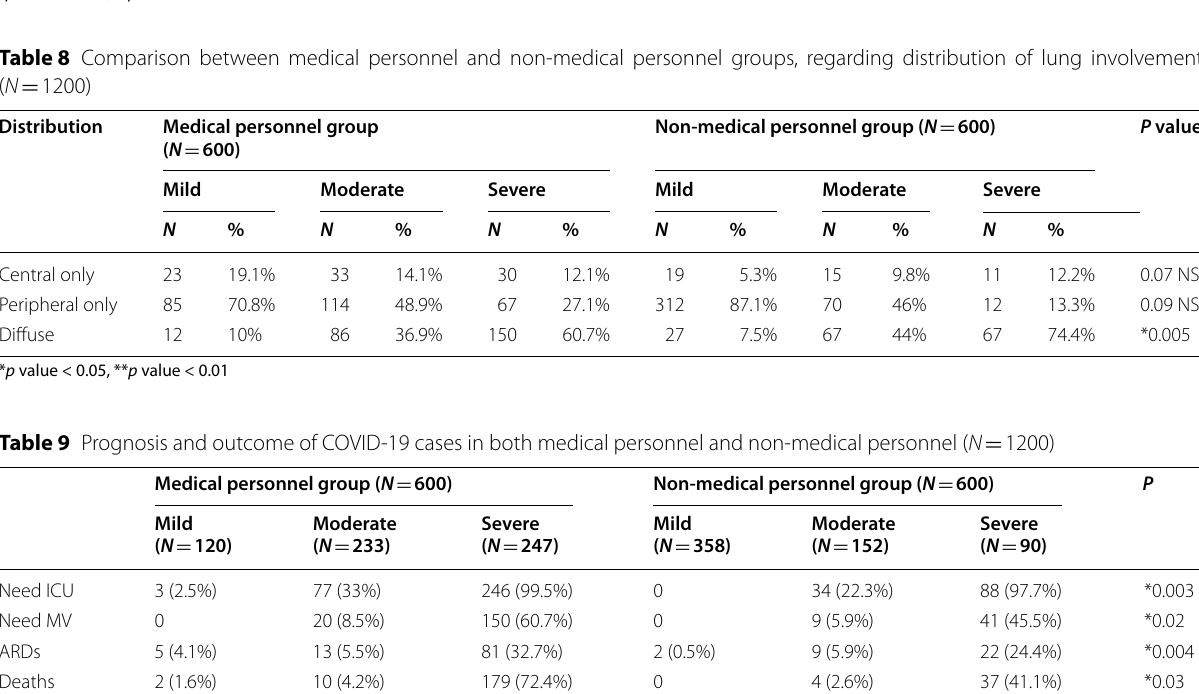
ICU, intensive case unit; MV, Mechanical ventilation; ARDs, adult respiratory distress syndrome; LOS, length of stay Independent t test Chi-square test * P considered significant if P < 0.05. Continues data represented as mean and standard deviation (SD), and categorical data as number and